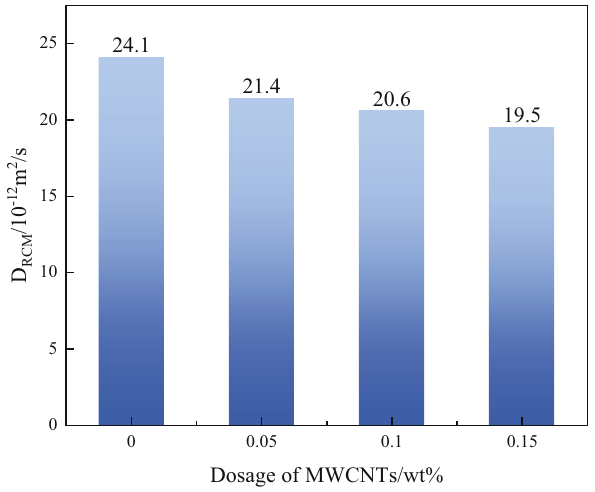
Figure 3: Unstable chloride ion di ff usion coe ffi cient D RCM of concrete with di ff erent dosage of MWCNTs [ 20 ]